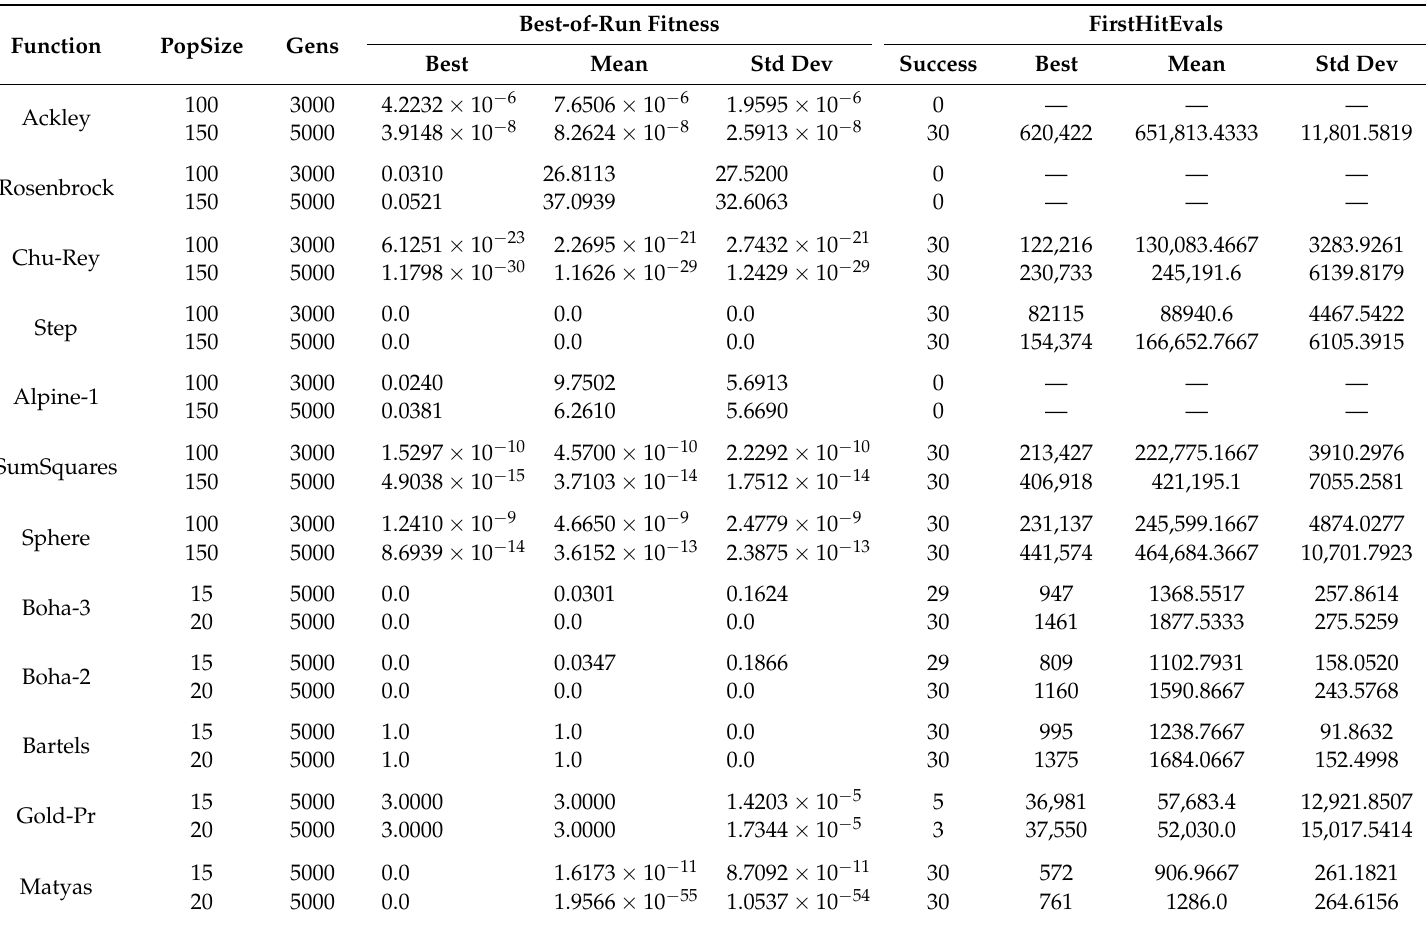
Table 3. Results of Jaya on the 12-function test-suite (each row corresponds to 30 independent runs). Most numbers are shown with rounding at the fourth place after the